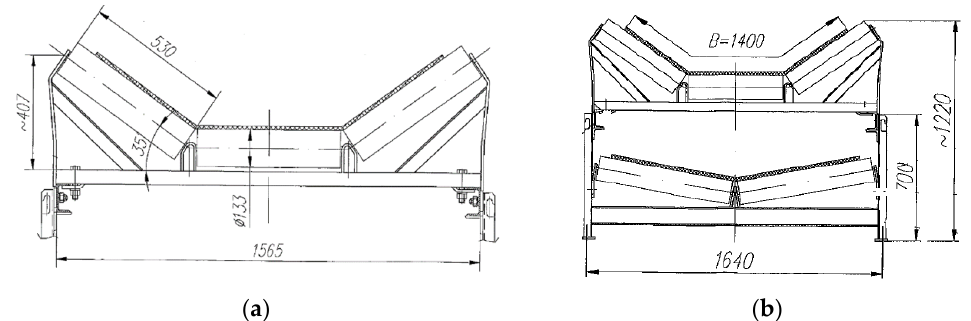
Figure 2. Support structure of the conveyor route: ( a ) The upper belt forms a trough with an angle of 35°; ( b ) View of the upper and lower belt routing.